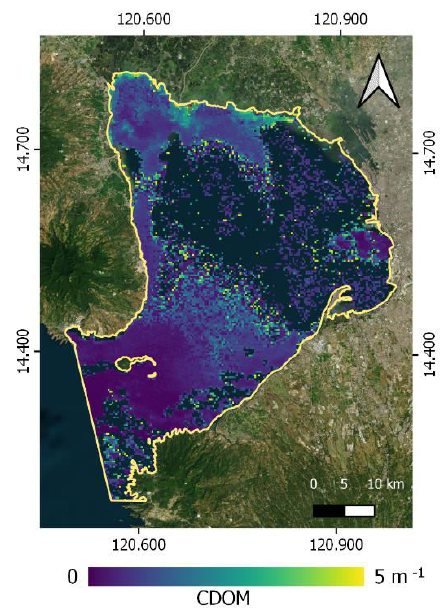
Figure 4. CDOM map using Sentinel-3 image from May 19,